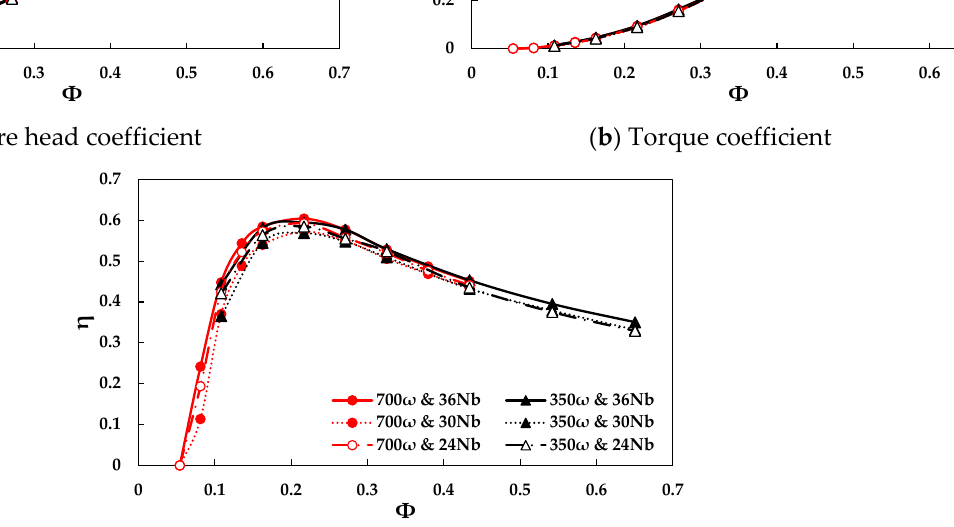
Figure 7. Effect of nozzle throat width on the turbine performance with 700 rpm and 3 mm blade thickness.